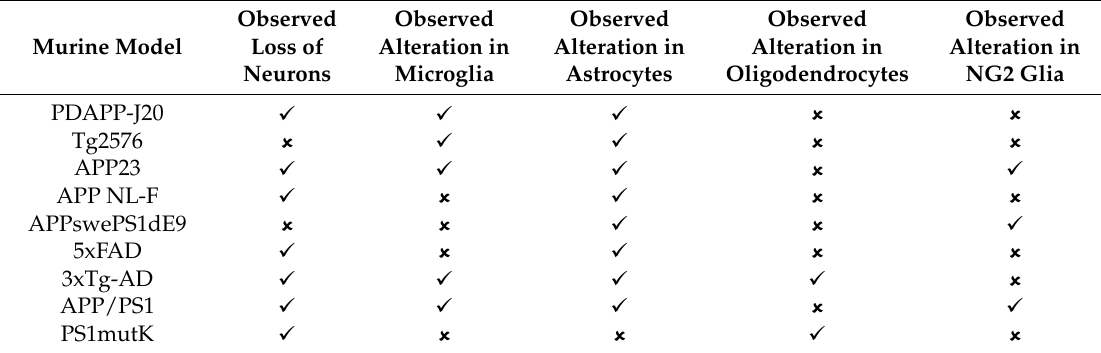
Table 1. Some well-studied murine models for Alzheimer’s Disease and observed alterations in specific types of glial